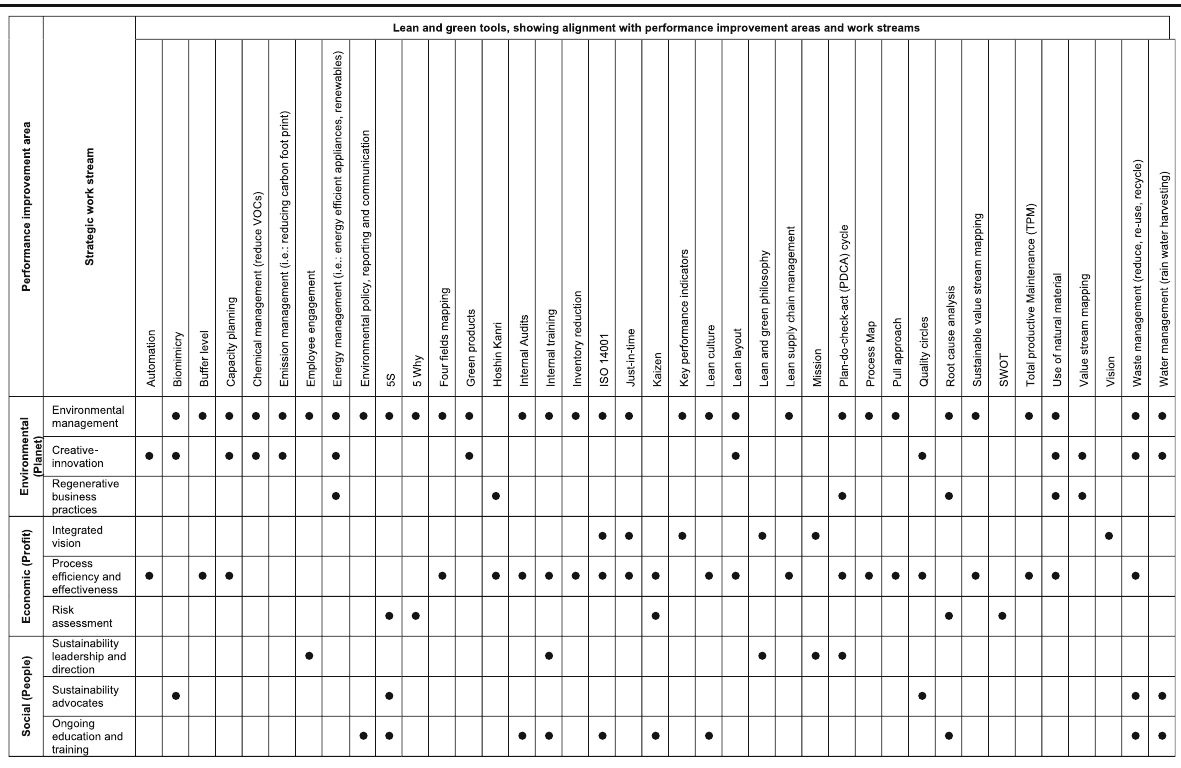
Table 7 3P Matrix for performance improvement towards lean and green business practice